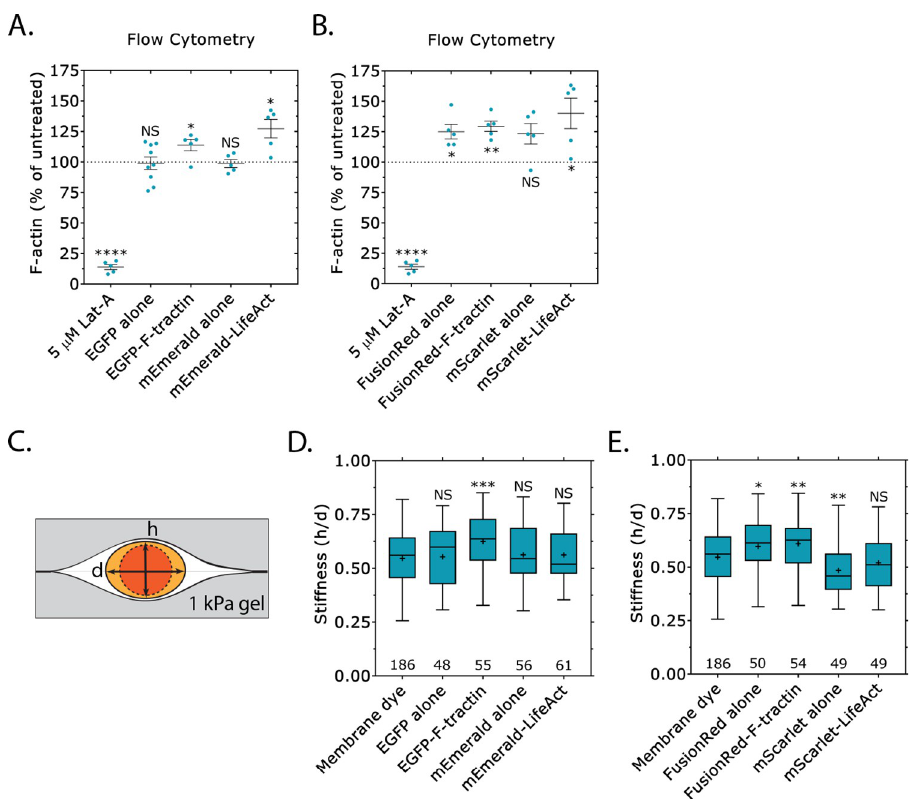
Fig 8. F-actin levels and cell stiffness is affected by fluorescent protein markers. A-B. Using a flow cytometry based assay, the total levels of F-actin were determined in freshly trypsinized (spherical) melanoma A375-M2 cells after transient transfection with EGFP alone, EGFP-F-tractin, mEmerald alone, mEmerald-LifeAct ( A ) or FusionRed alone, FusionRed-F-tractin, mScarlet alone, and mScarlet-LifeAct ( B ). Treatment with 5 μ M Latrunculin-A (Lat-A; 10 min) confirms the specificity of the approach. All data are normalized to untreated controls. C. Schematic representation of the cell stiffness assay in which cells are sandwiched between polyacrylamide (PA) gels of know stiffness (1 kPa). A ratio of the cell height ( h ) to the diameter ( d ) is used to define the cell stiffness. D-E. Using the cell stiffness assay shown in ( C ), the stiffness of melanoma A375-M2 cells transiently transfected with EGFP alone, EGFP-F-tractin, mEmerald alone, mEmerald-LifeAct ( D ) or FusionRed alone, FusionRed-F-tractin, mScarlet alone, and mScarlet-LifeAct ( E ) (“+” and line denote the mean and median, respectively). Statistical significance was determined using a One-way ANOVA and a Tukey’s post hoc test. All data are representative of at least three independent experiments. � —p � 0.05, �� —p � 0.01, ��� —p � 0.001, and ���� — p �